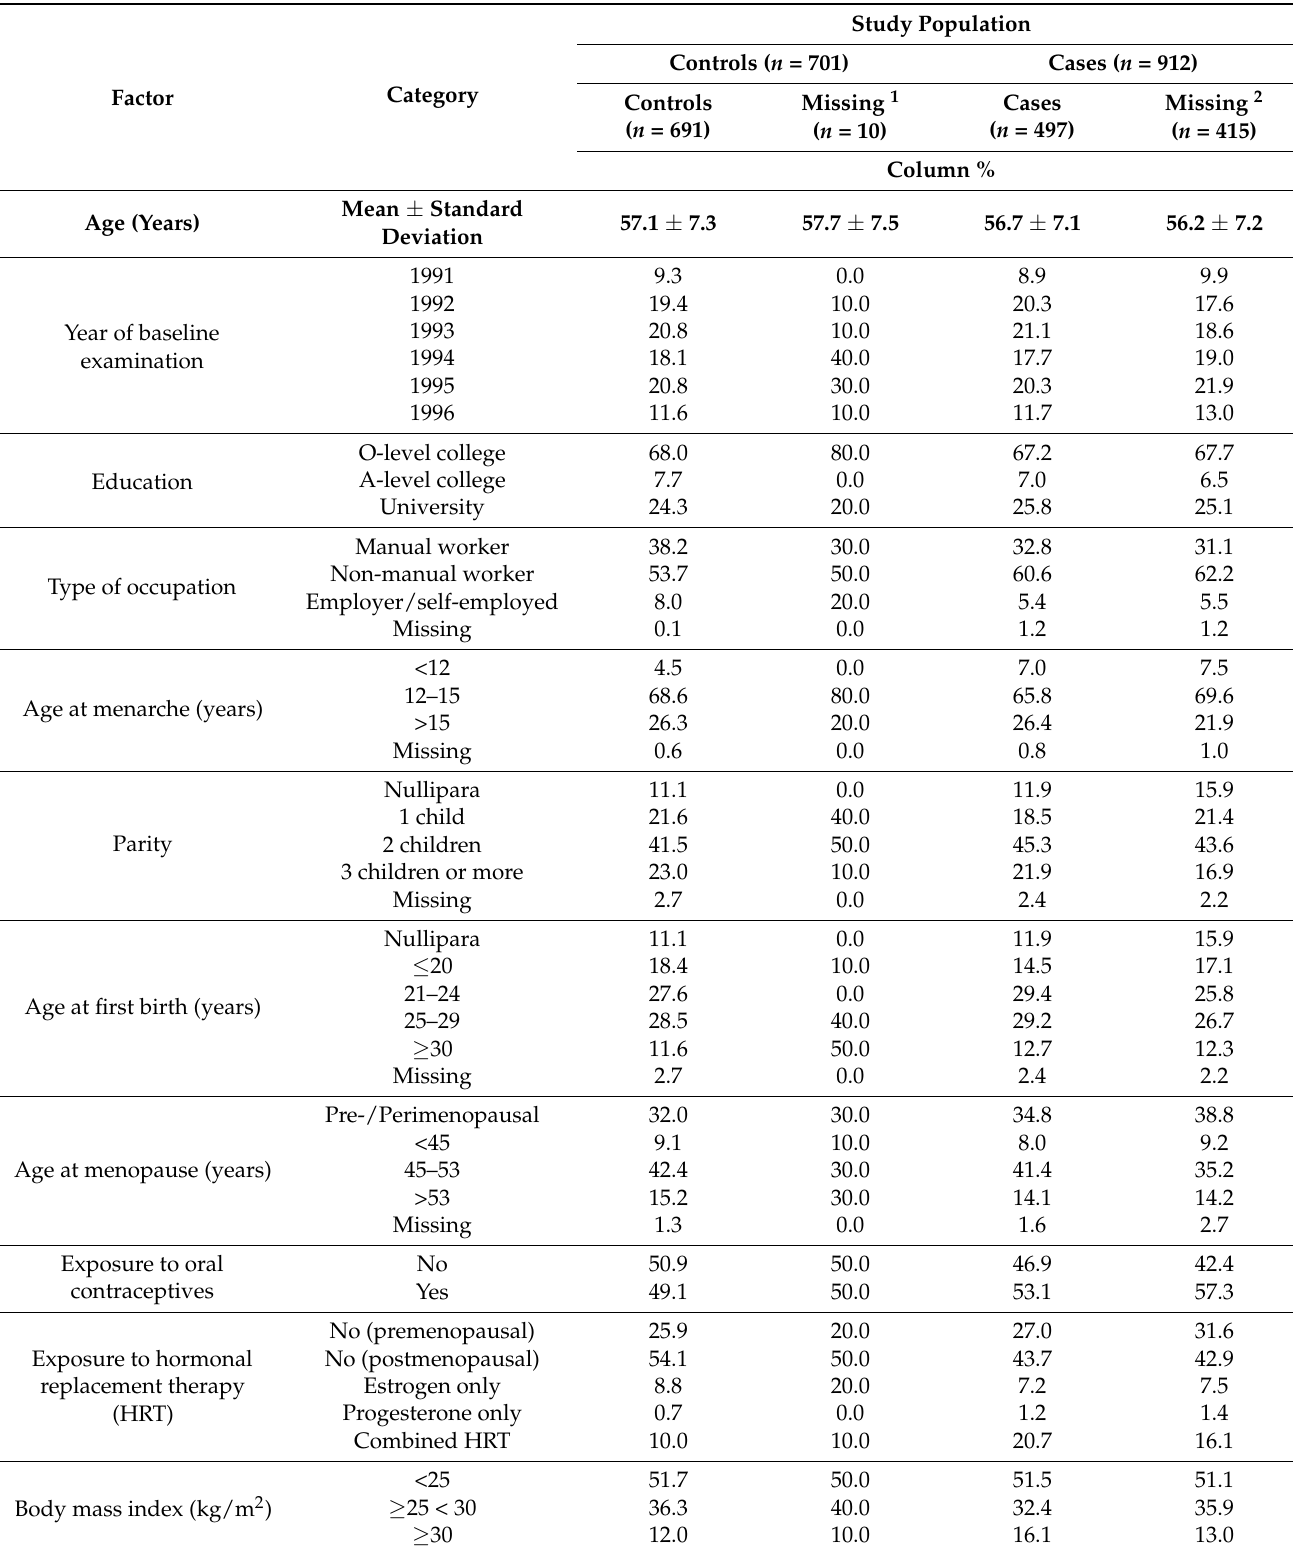
Table 1. Baseline characteristics of breast cancer cases and control